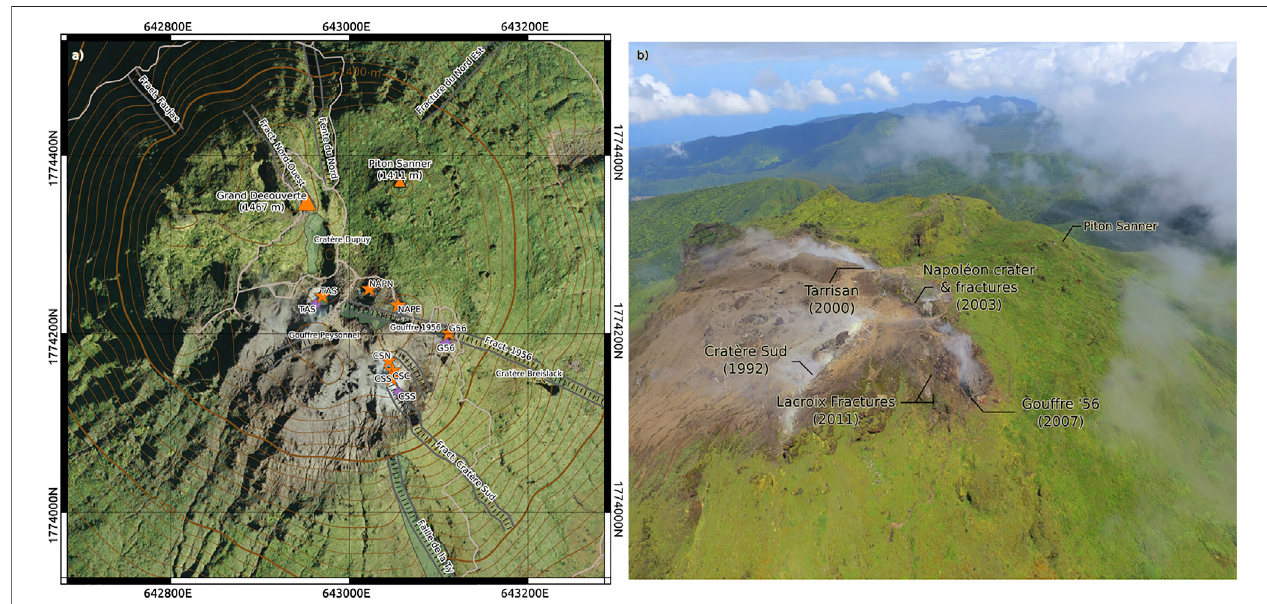
FIGURE1|(A) Map ofthesummitofLaSoufrièredeGuadeloupe (1467asl)showingthemaingeologicalfeatures/fractures, thelocationofthefumaroles sampled via the MultiGas portable (orange stars: Tarissan, TAS; Cratère Sud-Sud, CSS; Cratère Sud-Centre, CSC; Cratère Sud-Nord, CSN; Gouffre 56, G56; Napoléon Nord, NAPN; Napoléon Est, NAPE) and the location of the three permanent MultiGas stations (purple stars; G56: 643,545 E, 1774499 N; TAS: 643,388 E, 1774541 N; CSS: 643,489 E, 1774441 N). Modi fi ed from Jessop et al.(2021). (B) Photo ofthe main active fumaroles with the dateof appearance in brackets.Modi fi ed from Jessop et al.